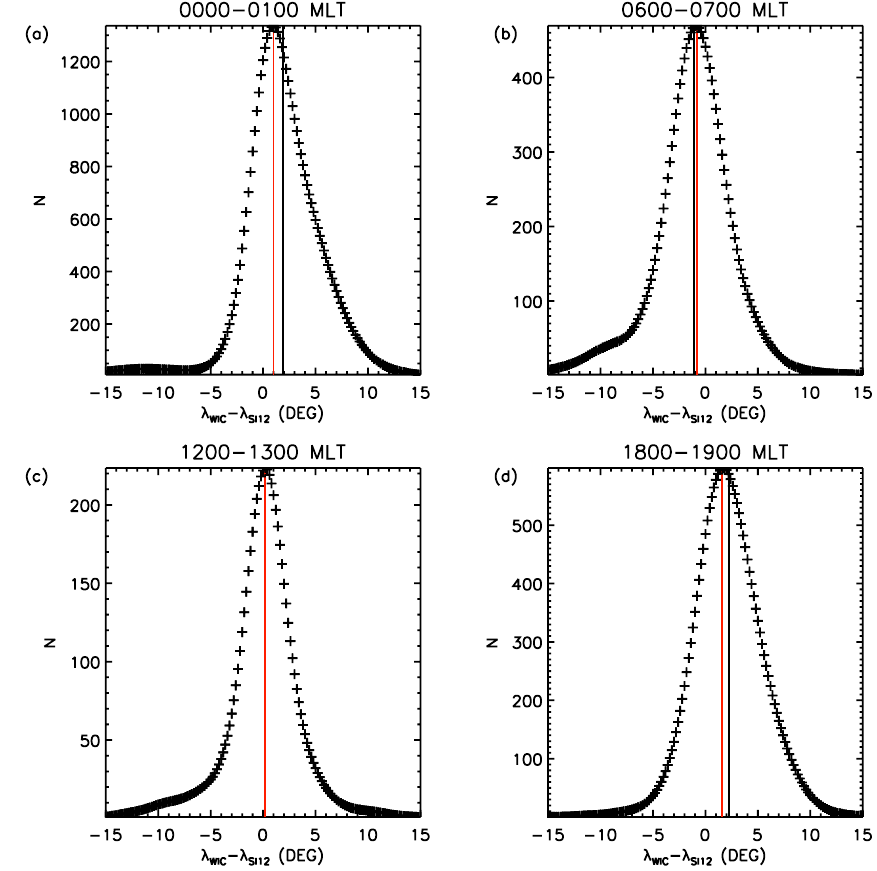
Fig. 2. Frequency distribution of the difference between the latitude of WIC and SI-12 OCB proxies for 00:00–01:00, 06:00–07:00, 12:00– 13:00 and 18:00–19:00MLT. Crosses represent the number of boundary differences in 0.2 ◦ bins of magnetic latitude, red vertical lines represent the mode of the distribution and black vertical lines the mean.